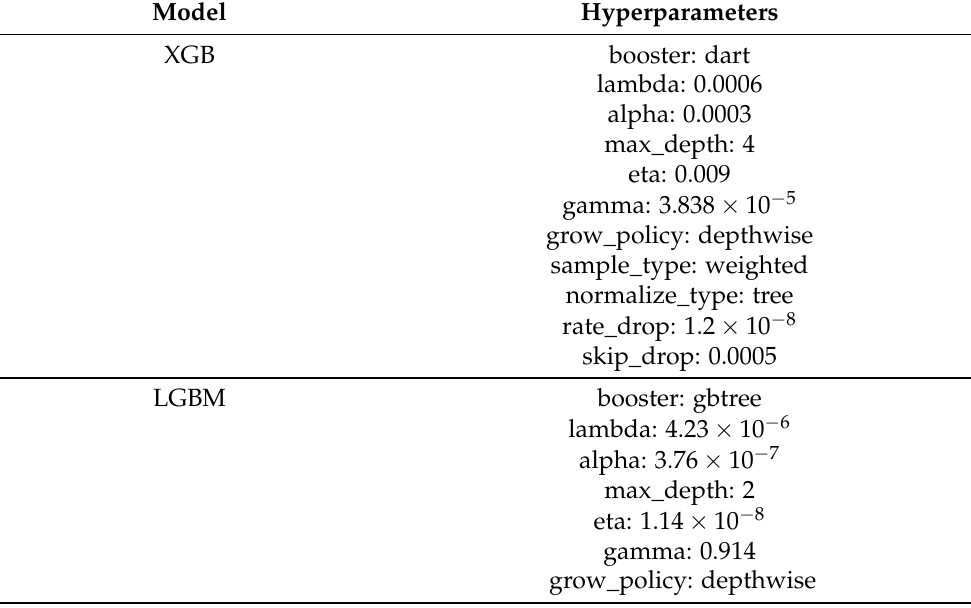
Table A10. Optimal hyperparameters for all ML models attained through tuning for 6 feature PSG